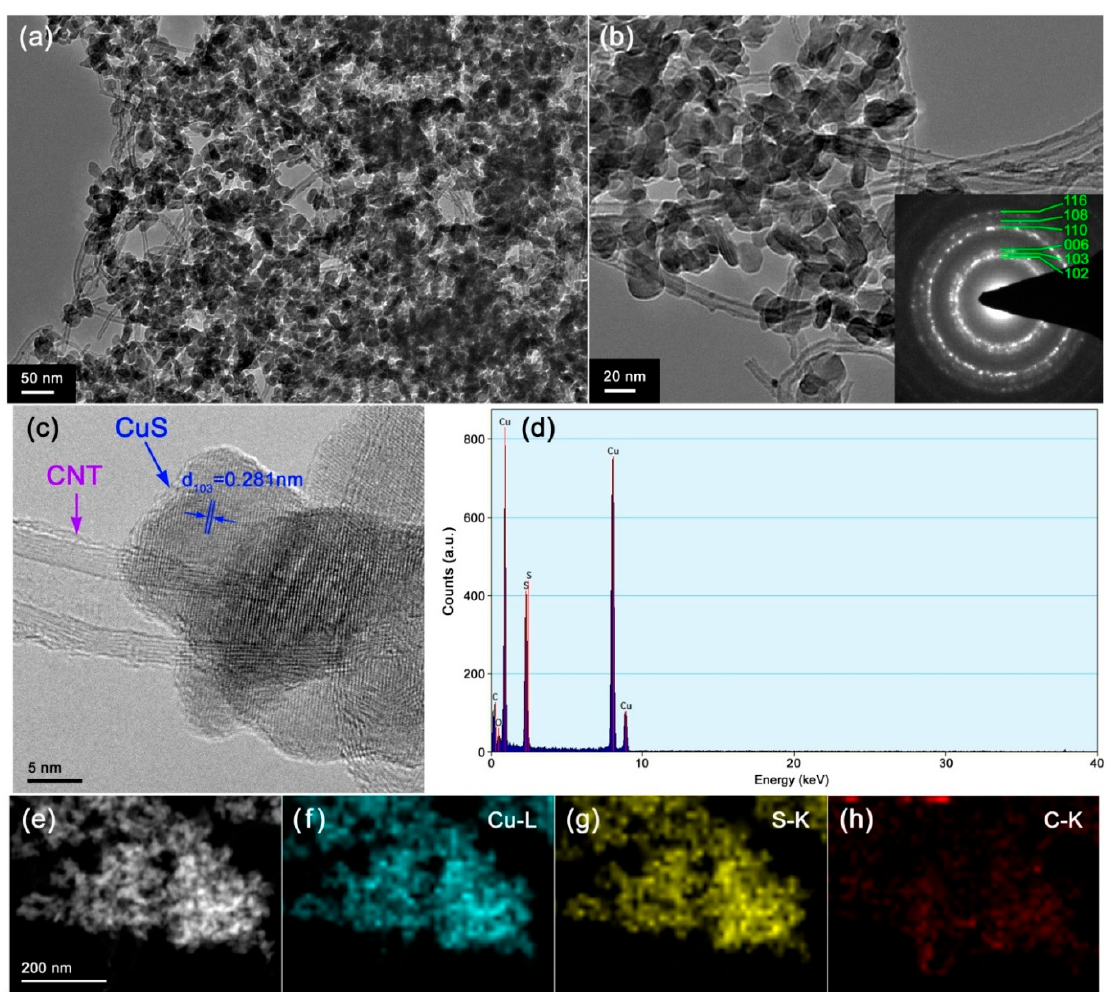
Figure 6. Transmission electron microscopy (TEM) images ( a , b ), selected area electron diffraction (SAED) pattern (inset in ( b )), high-resolution TEM (HRTEM) image ( c ), Energy-dispersive X-ray spectroscopy (EDS) spectrum ( d ), dark-field scanning TEM (DF-STEM) image ( e ), and EDS elemental mapping images ( f – h ) of the 3% CNT/CuS composite.